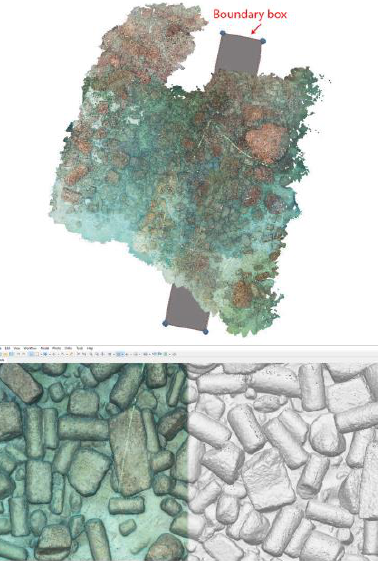
Figure 10. Above, resized boundary box using “ split in chunk s” script; below, the dense point cloud (150 million points) processed in low setting quality (Mohamed Abdelaziz)